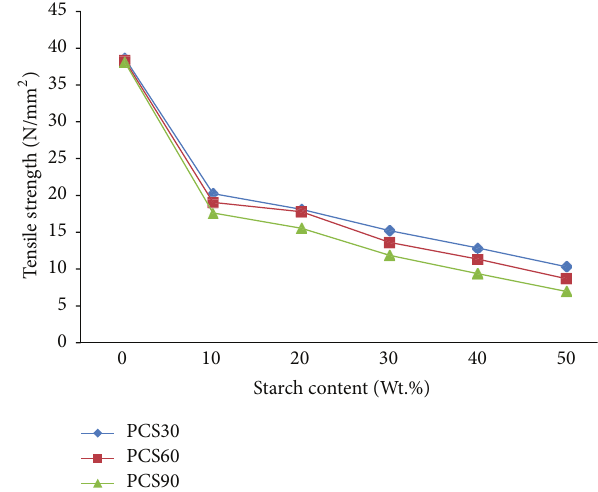
Figure 1: Tensile strength of PP/PCS blends after the soil burial